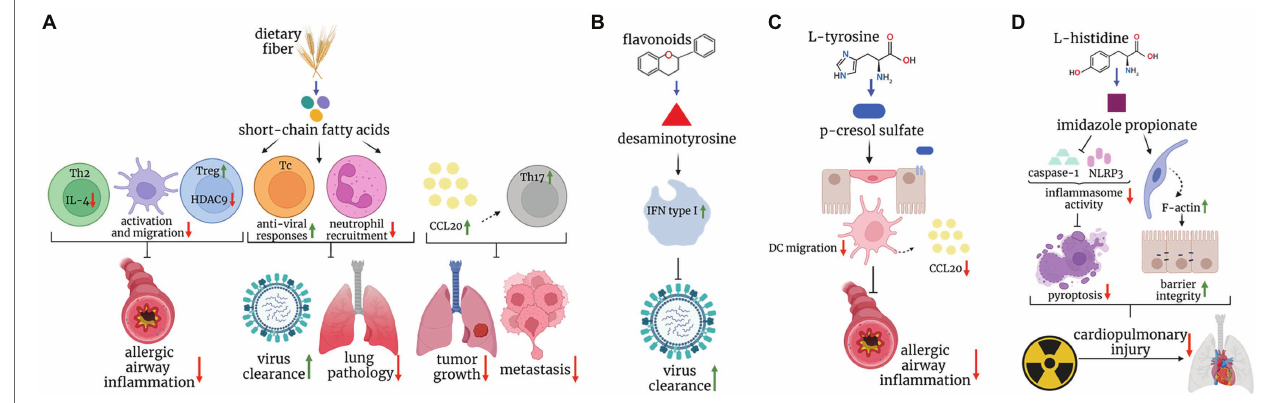
FIGURE 1 | Postbiotics in mouse models of lung disease. (A) Short-chain fatty acids, major breakdown products of dietary fiber inhibit dendritic cell and Th2 responses, and augment regulatory T cell response, protecting mice against allergic airway inflammation. They also boost protective CD8 + T cell immunity against the influenza virus, and limit cytotoxic effects of neutrophils, leading to increased viral clearance and reduced immunopathology, respectively. Finally, they enhance the CCL20-Th17 axis to reduce tumor growth and metastasis. (B) Desaminotyrosine, derived from the metabolism of flavonoids augments type I interferon signaling in phagocytes and protects mice against influenza virus infection. (C) P-cresol sulfate, a product of L-tyrosine metabolism, inhibits the production of CCL20 and dendritic cell migration in the lungs, ultimately reducing allergic airway inflammation. (D) Imidazole propionate, derived from L-histidine, reduces the inflammasome activity and increases F-actin expression, leading to reduced pyroptosis and improved barrier integrity, respectively, and ultimately ameliorating cardiopulmonary injuries caused by